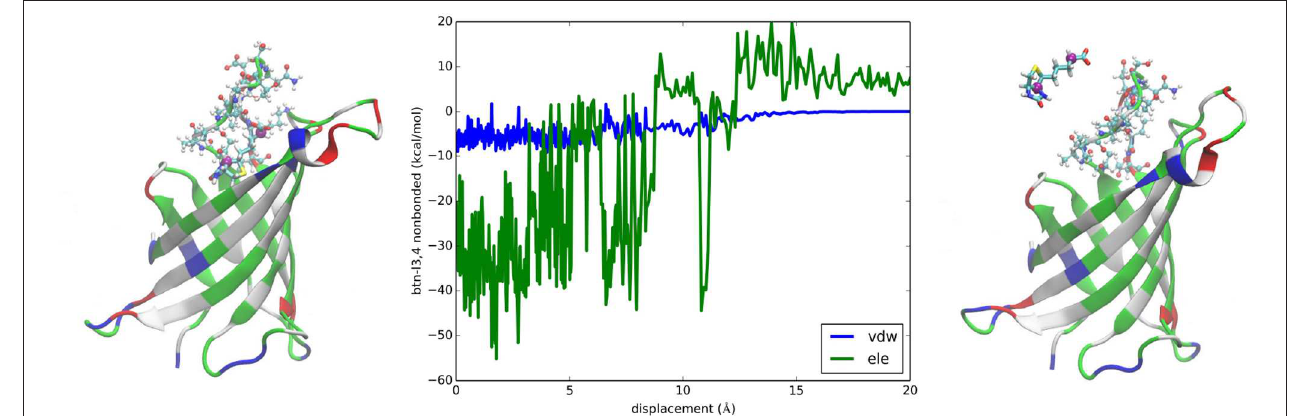
FIGURE 5 | Interactions between biotin and L3,4 of avidin. Plotted in the central panel are the van der Waals and the electrostatic interactions between biotin and L3,4 along the dissociation path. The left and the right panels show the bound and the unbound states of BTN-AVD, respectively. The whole protein is shown as ribbons colored by residue types. The L3,4 residues are shown in ball-and-sticks colored by atom names. BTN is shown in licorices colored by atom names whose C4 and C10 atoms are shown as purple